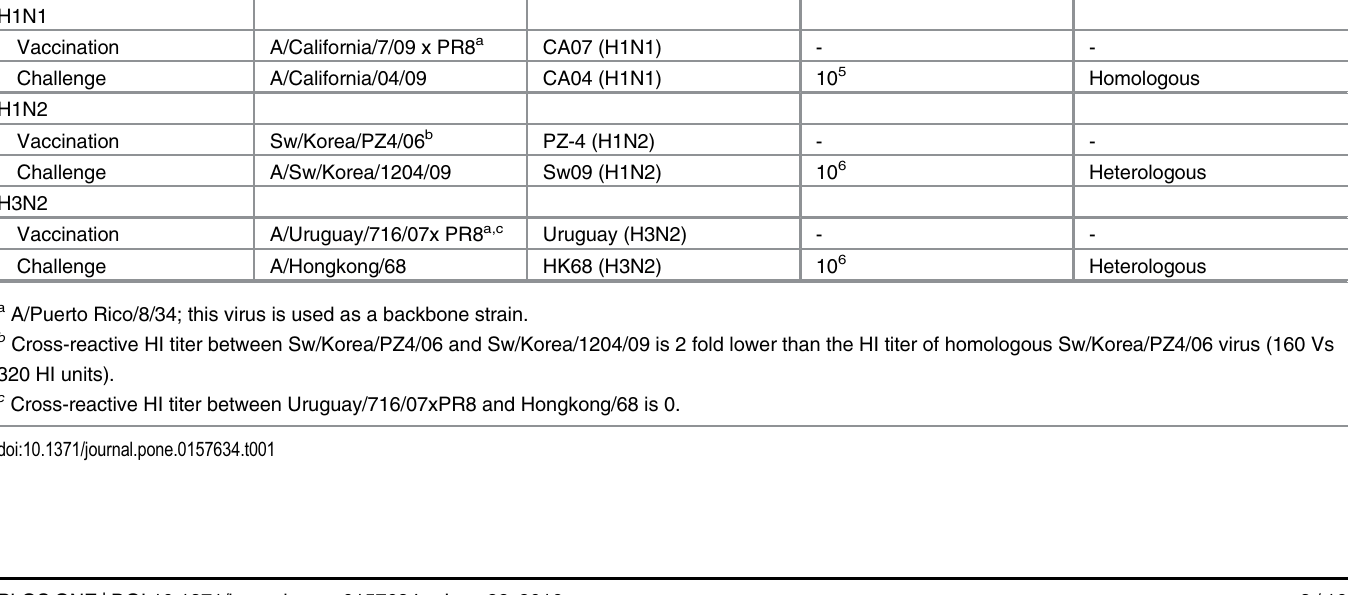
Table 1. List of influenza viruses used for vaccination and challenge in this study. Group